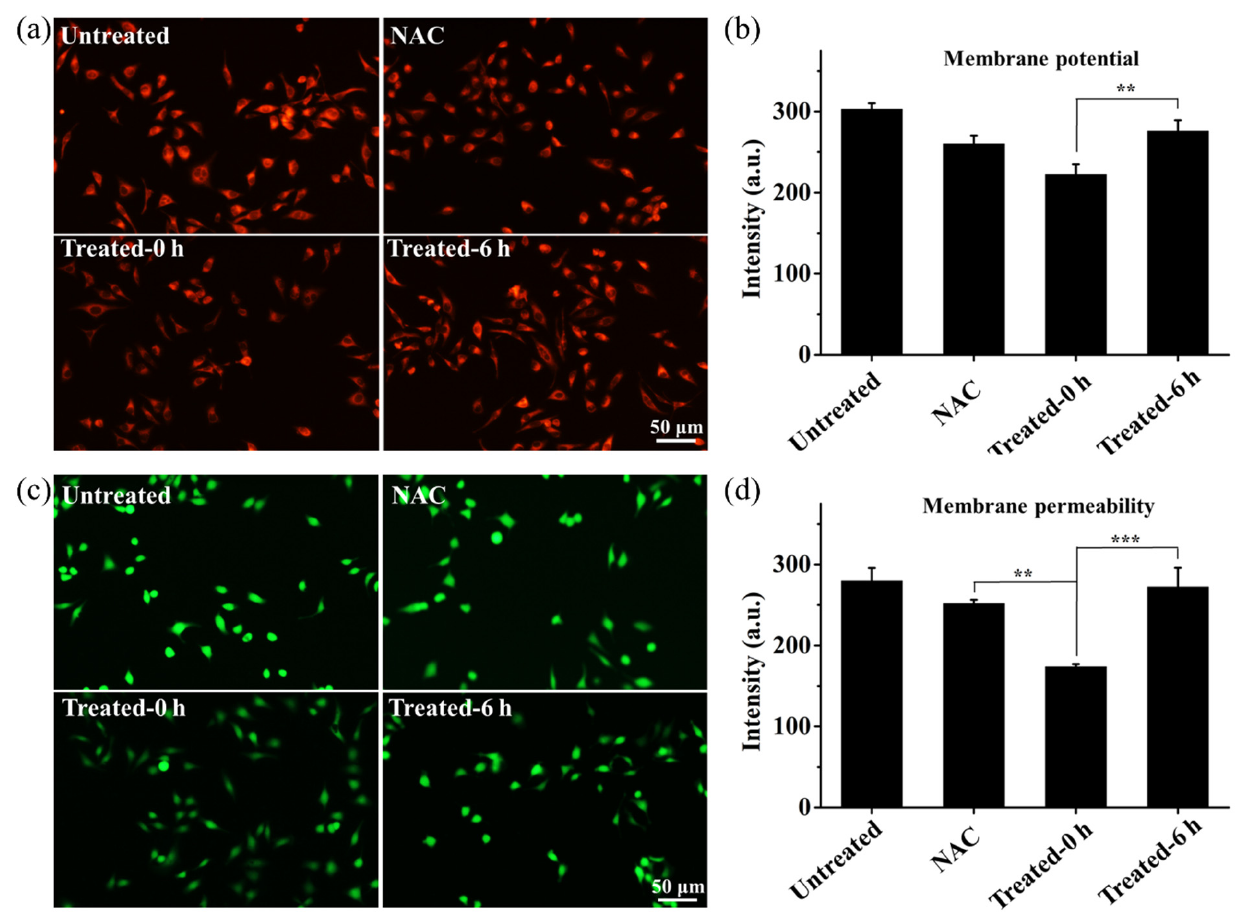
Figure 6. Determination of the membrane potential and permeability after the CAP treatment: ( a ) Fluorescence images and ( b ) Intensity changes observed from the MCF-7 cells stained with Rh123 upon CAP exposure of 80 s under different conditions to determine the membrane potential alteration; ( c ) Fluorescence images and ( d ) Intensity changes observed from the MCF-7 cells stained with FDA after the CAP treatment for 80 s under different conditions to evaluate of membrane permeability changes. The data are shown as mean ± SD ( n = 3). (**) p < 0.01, and (***) p < 0.001.